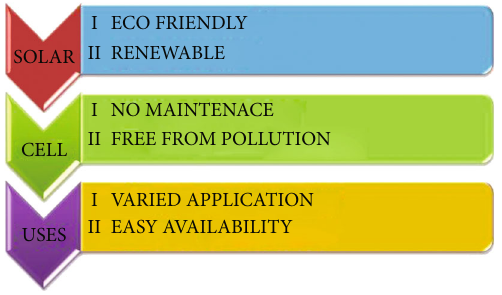
Figure 1: Uses of solar